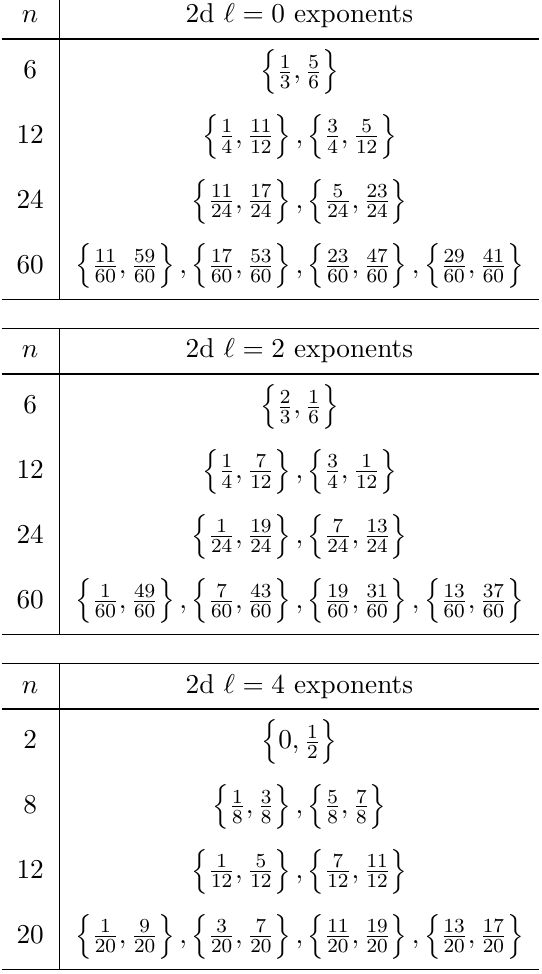
Table 3 . Possible exponents mod 1 for two-character theories with ‘ = 0 , 2 , 4 mod